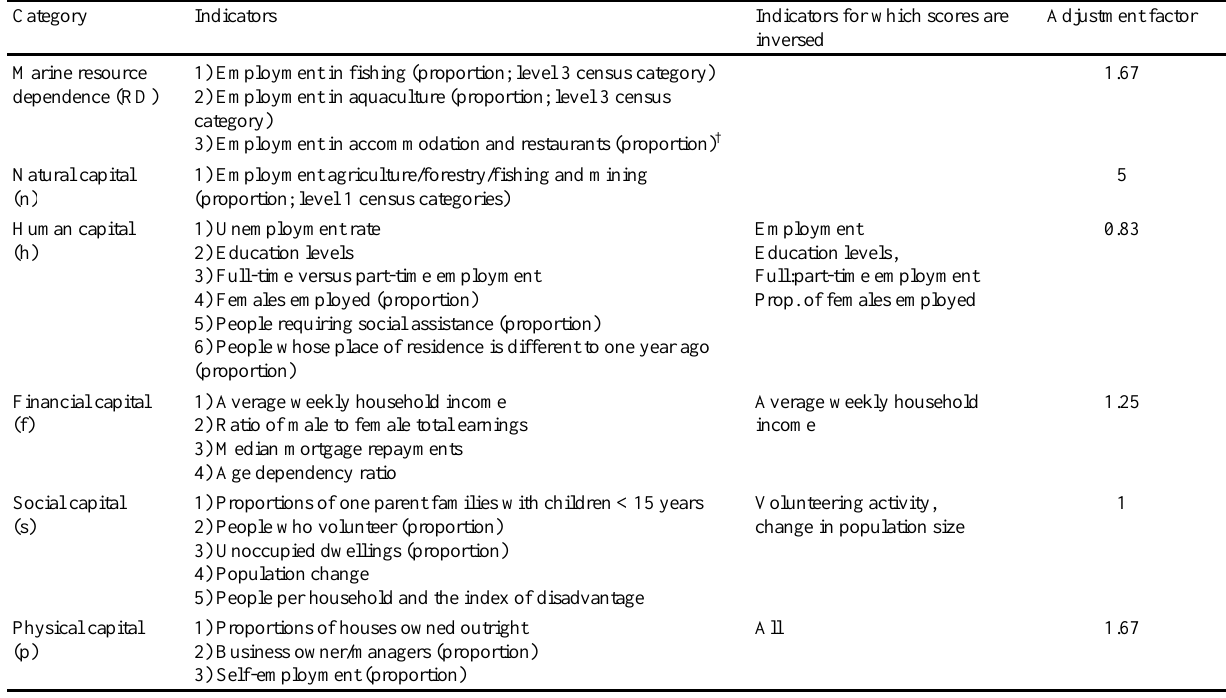
Table 6. Indicators and scoring used to calculate the value of the five capital assets and marine resource dependence. Each indicator has an initial maximum possible value of 2 and a minimum of 0 where indicator value < Australian average, then = 0 (good), Australian average < indicator value > max state value, then = 1 (moderate), indicator value > max state value, then = 2 (poor). To compare the scores across all capitals, the values were then adjusted to be out of 10, i.e., if 10.00 < sum(indicators) × adjustment factor > 6.67, low (i.e., poor), if 6.67 < sum(indicators)